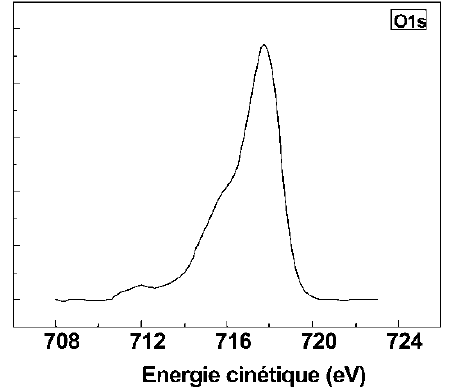
FIGURE 3c Spectre du niveau de cœur O1s dans le TiO 2